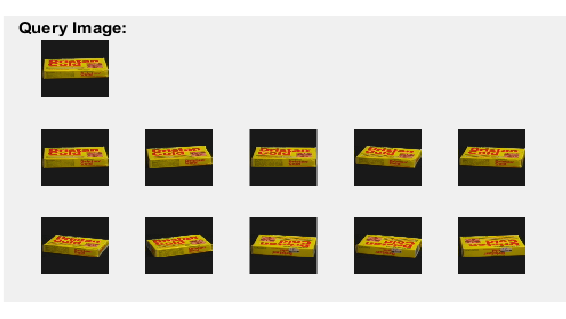
Figure 9. Retrieved top 10 images by proposed method from Corel-1K dataset